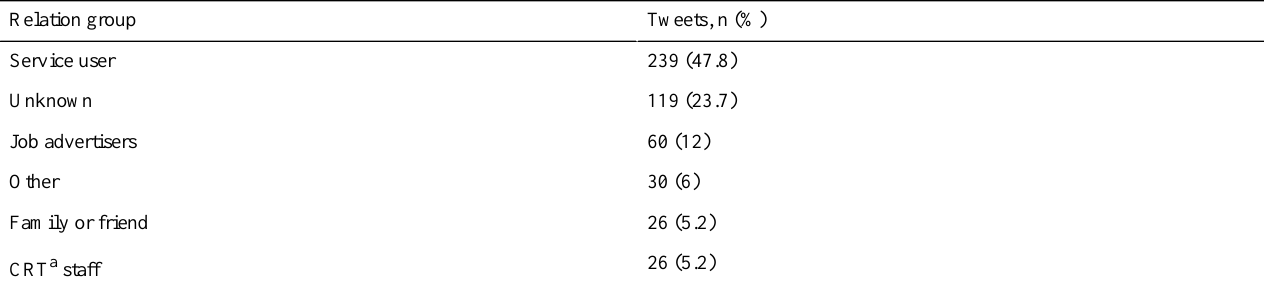
Table 2. Twitter user relation groups (who was tweeting) for analyzed tweets